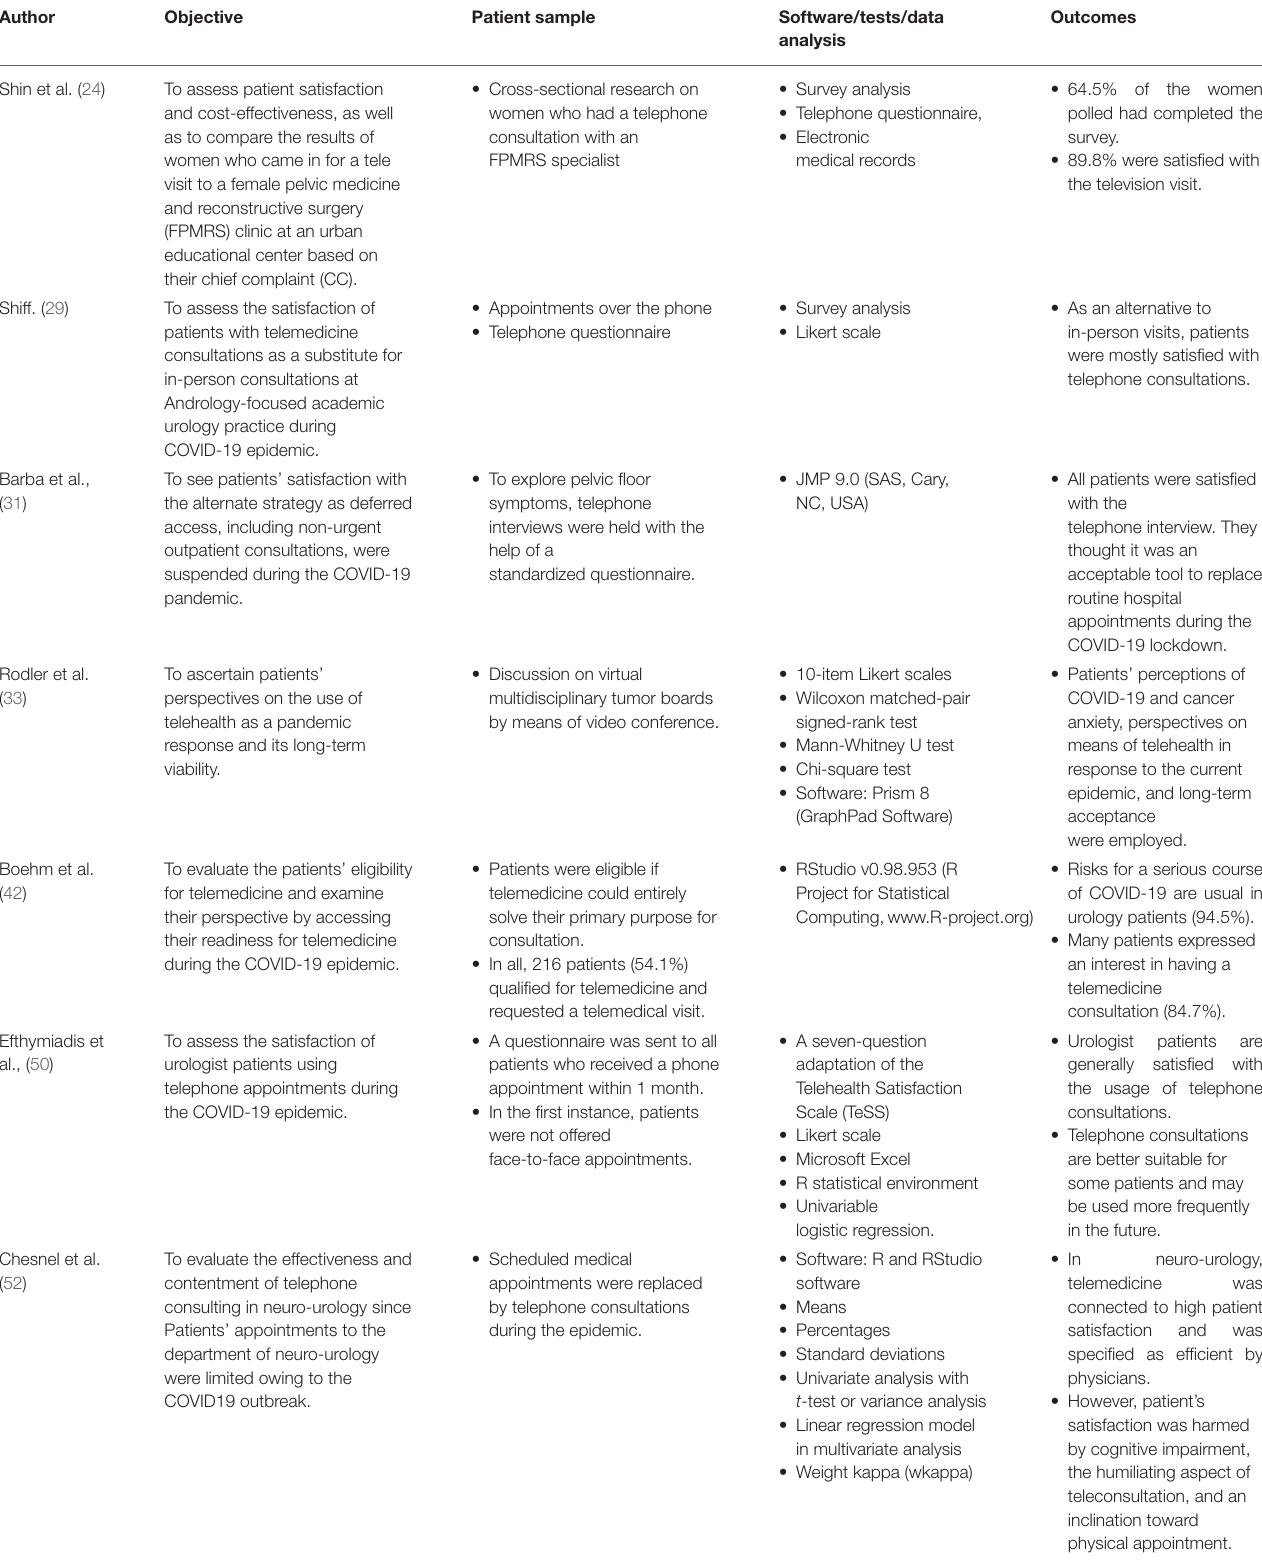
TABLE 1 | Summary of recent studies on telemedicine and telehealth in urology based on patient’s